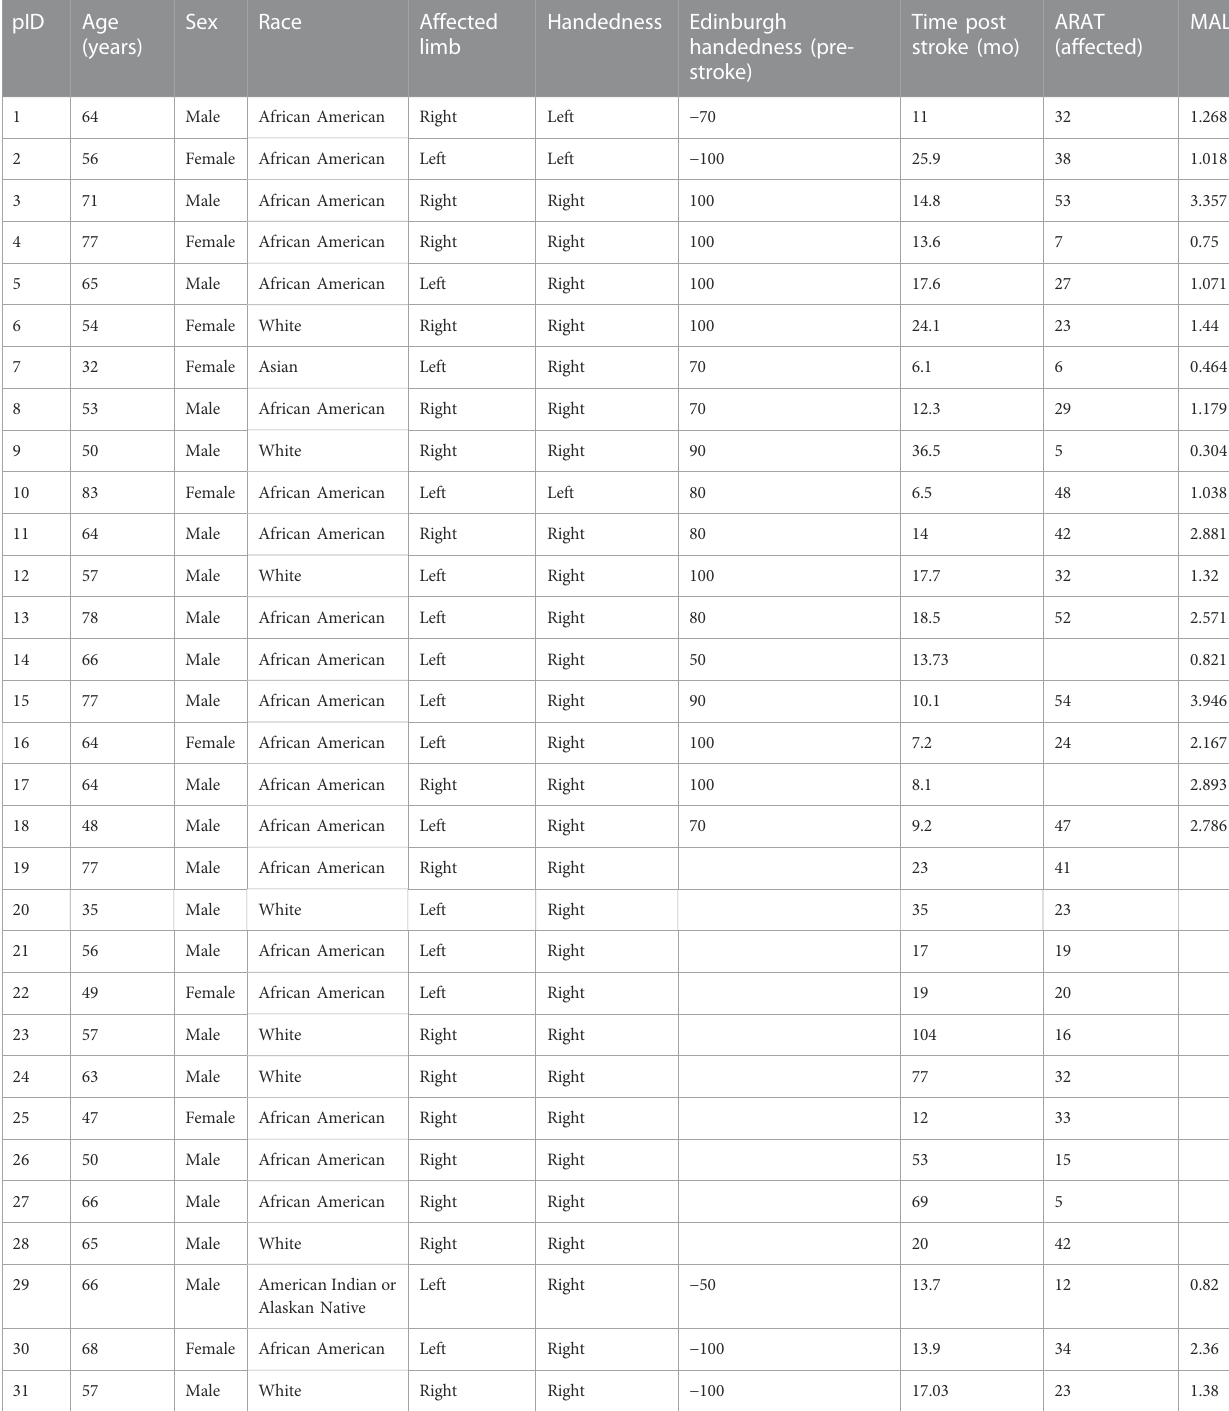
Table 1. Participant characteristics. Empty cells indicate missing